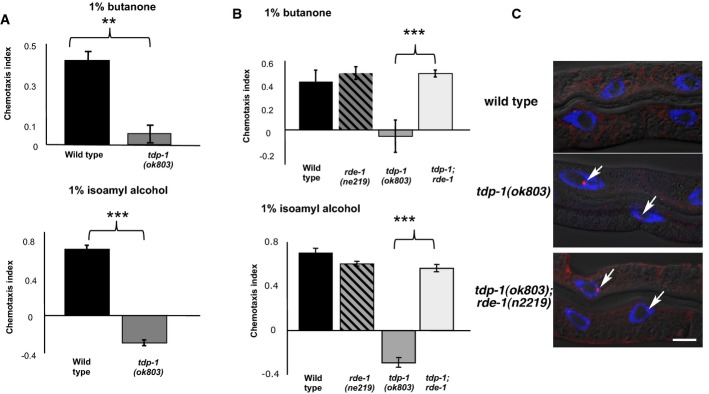
TDP-1 maintains chemotaxis by limiting RNA interferenceThe chemotaxis index (y-axis) for wild-type and tdp-1(ok803) animals toward 1% butanone and 1% isoamyl alcohol are shown. Negative values signify repulsion. Error bars represent SEM. **P < 0.01, ***P < 0.001 (Student's t-test).Rescue of chemotaxis toward 1% butanone (top two graphs) and 1% isoamyl alcohol (bottom two graphs) in tdp-1(ok803);rde-1(ne219) double-mutant animals. Assays were done in triplicates at least 3 independent times. Error bars represent SEM. ***P < 0.001 (Student's t-test).Immunostaining of isolated worm nuclei in wild-type, tdp-1(ok803) mutants and tdp-1(ok803); rde-1(n2219) double mutants. Single plane images distally overlaid with DIC image. The presence of J2 foci in tdp-1(ok803); rde-1(n2219) mutants indicates that deletion of rde-1 does not suppress the accumulation of dsRNA in tdp-1 mutants.